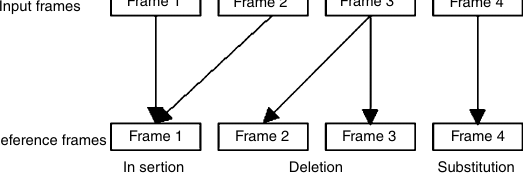
Table 1 Resulting processing times and recognition